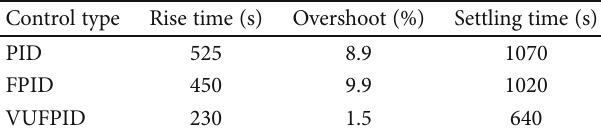
Figure 7: System response curve. Table 2: Performance parameter